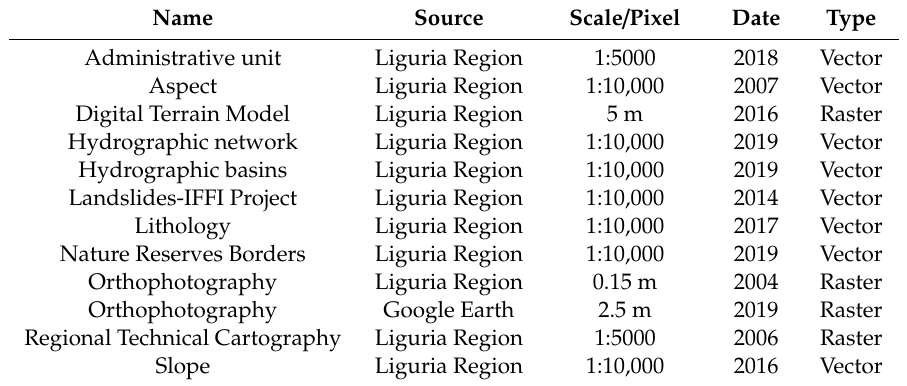
Table 1. Vector and raster data used. IFFI (Italian Landslide Inventory) [92]; DTM (Digital Terrain Model).